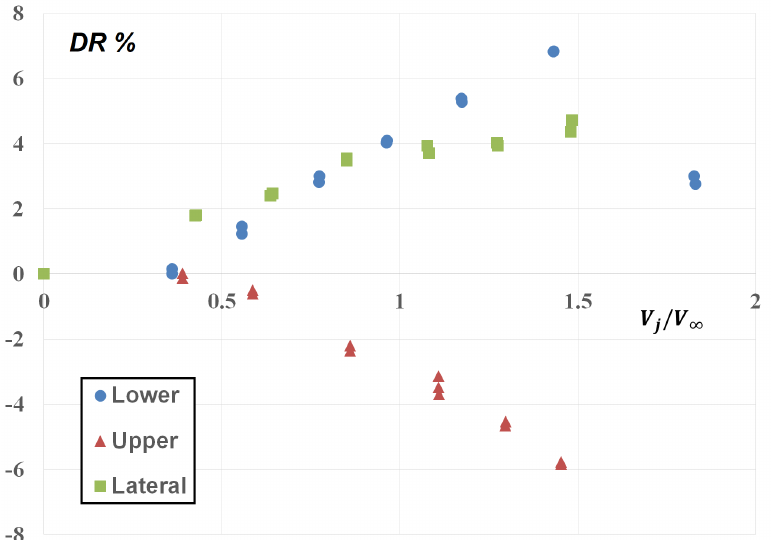
Figure 5. Effect of single jets actuation on drag